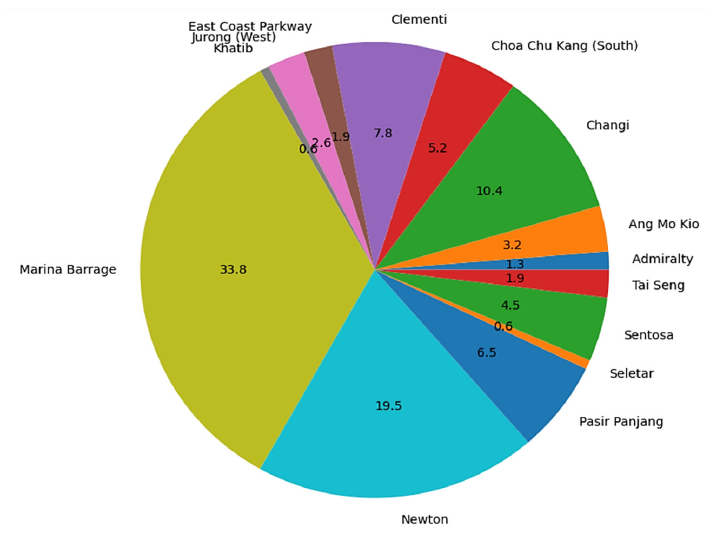
Figure 11. Cumulative distribution of Green Mark Buildings registered in Singapore (rounded up to 1 decimal point).